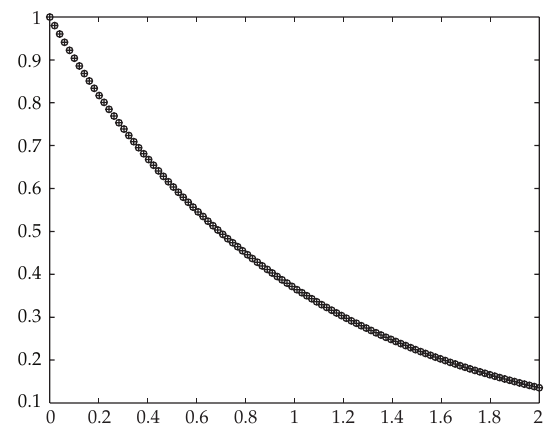
Figure 7: Index 3, T (cid:8) 2, the y 2 -coordinate, “o”-original, “ (cid:9) ”-approximation.